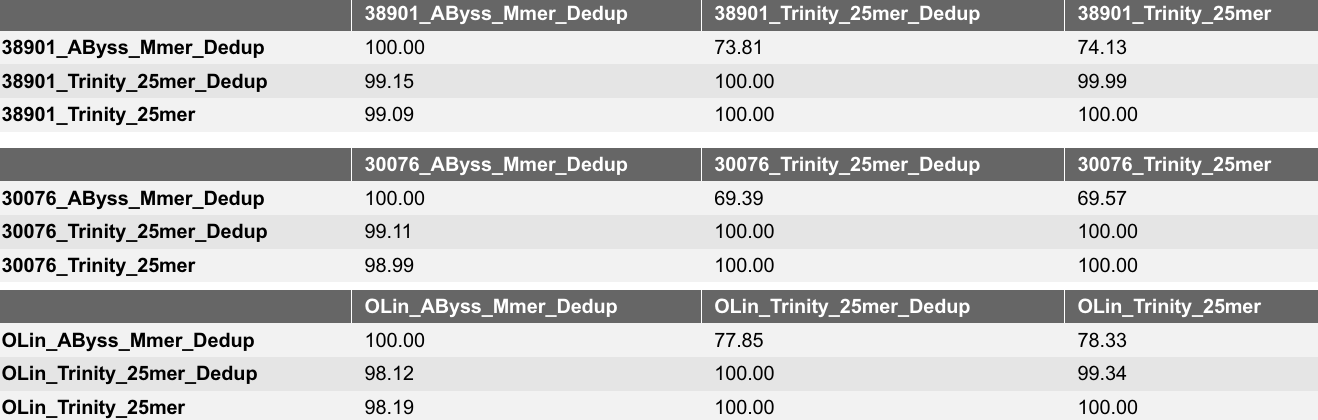
Table 4. Assemblies compared in a pair-wise fashion using Mummer, and the proportions covered from each of the assemblies are shown below.